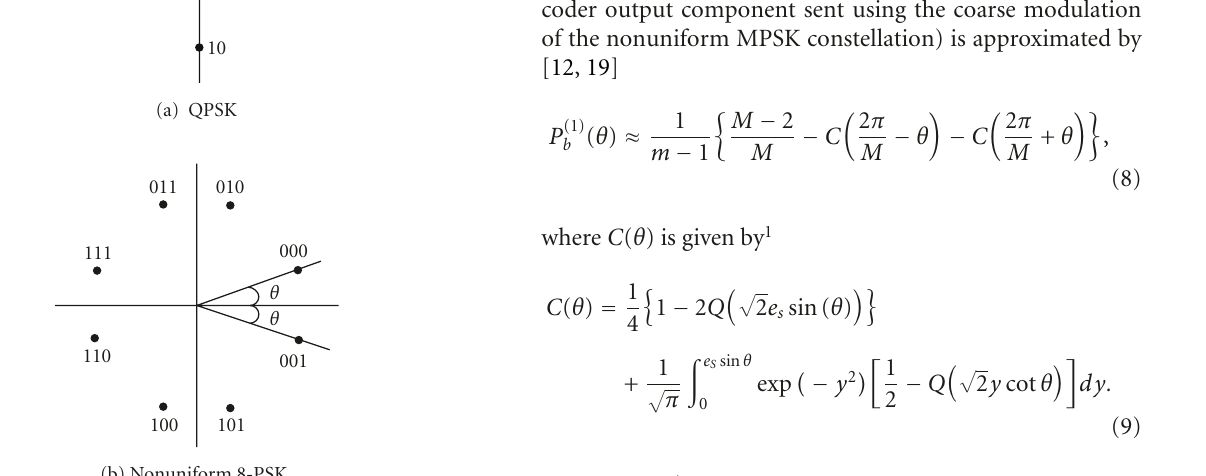
Figure 2(b); the error bounds for uniform QPSK and 8-PSK constellation are special cases with θ = 0 and π/ 8, respec- tively. We make use of these same bounds in our work to evaluate the error probability for the base layer and the